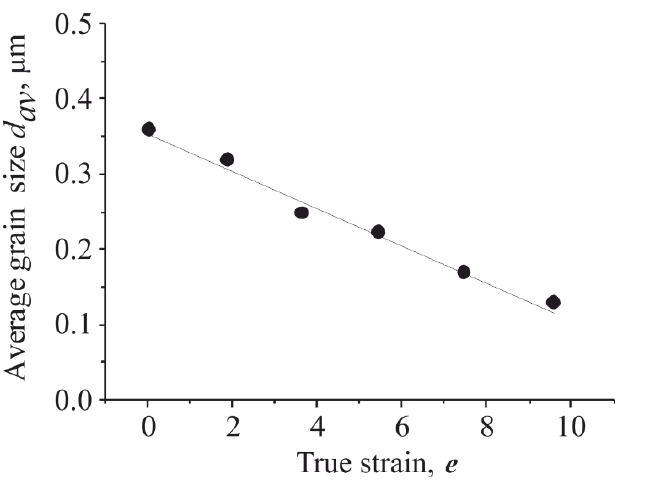
Figure 8. Average grain – subgrain size d av versus true abc strain in Ti 49.8 Ni 50.2 according to TEM.